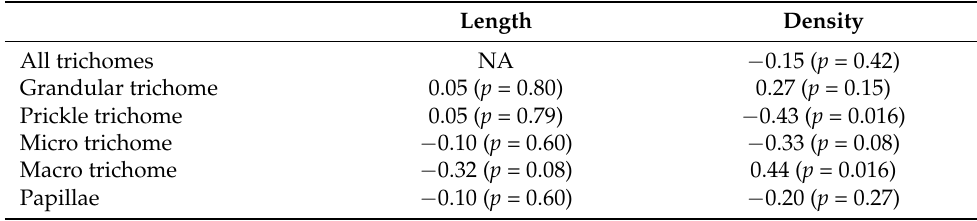
Table 5. Spearman’s rank correlation ( ρ ) of injury level and the physical characteristics of trichomes on 10 rice